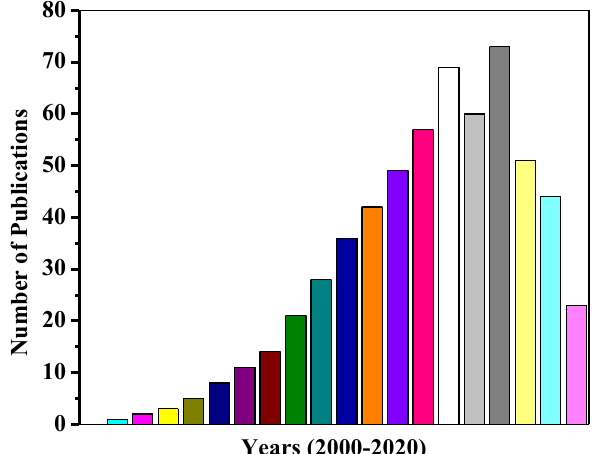
Fig. 10. Year wise statistics for the colorimetric detection of Hg 2+ ion using functionalized AgNPs (2000-2020, Left to Right).